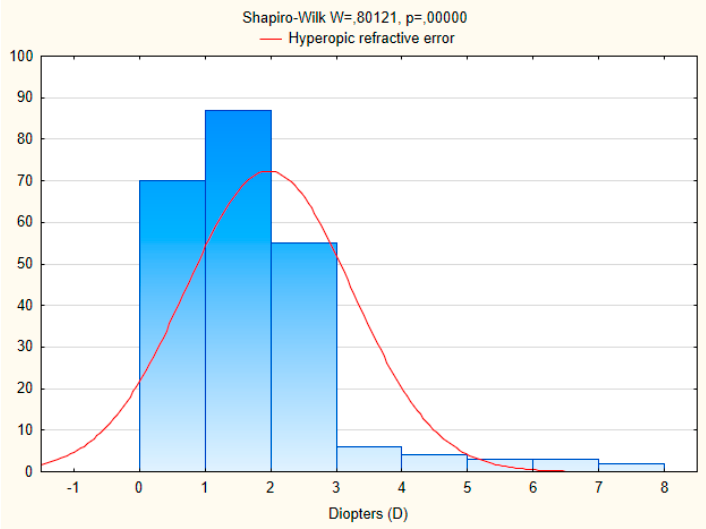
Figure 2. Histogram of hyperopic refractive error in the researched population.